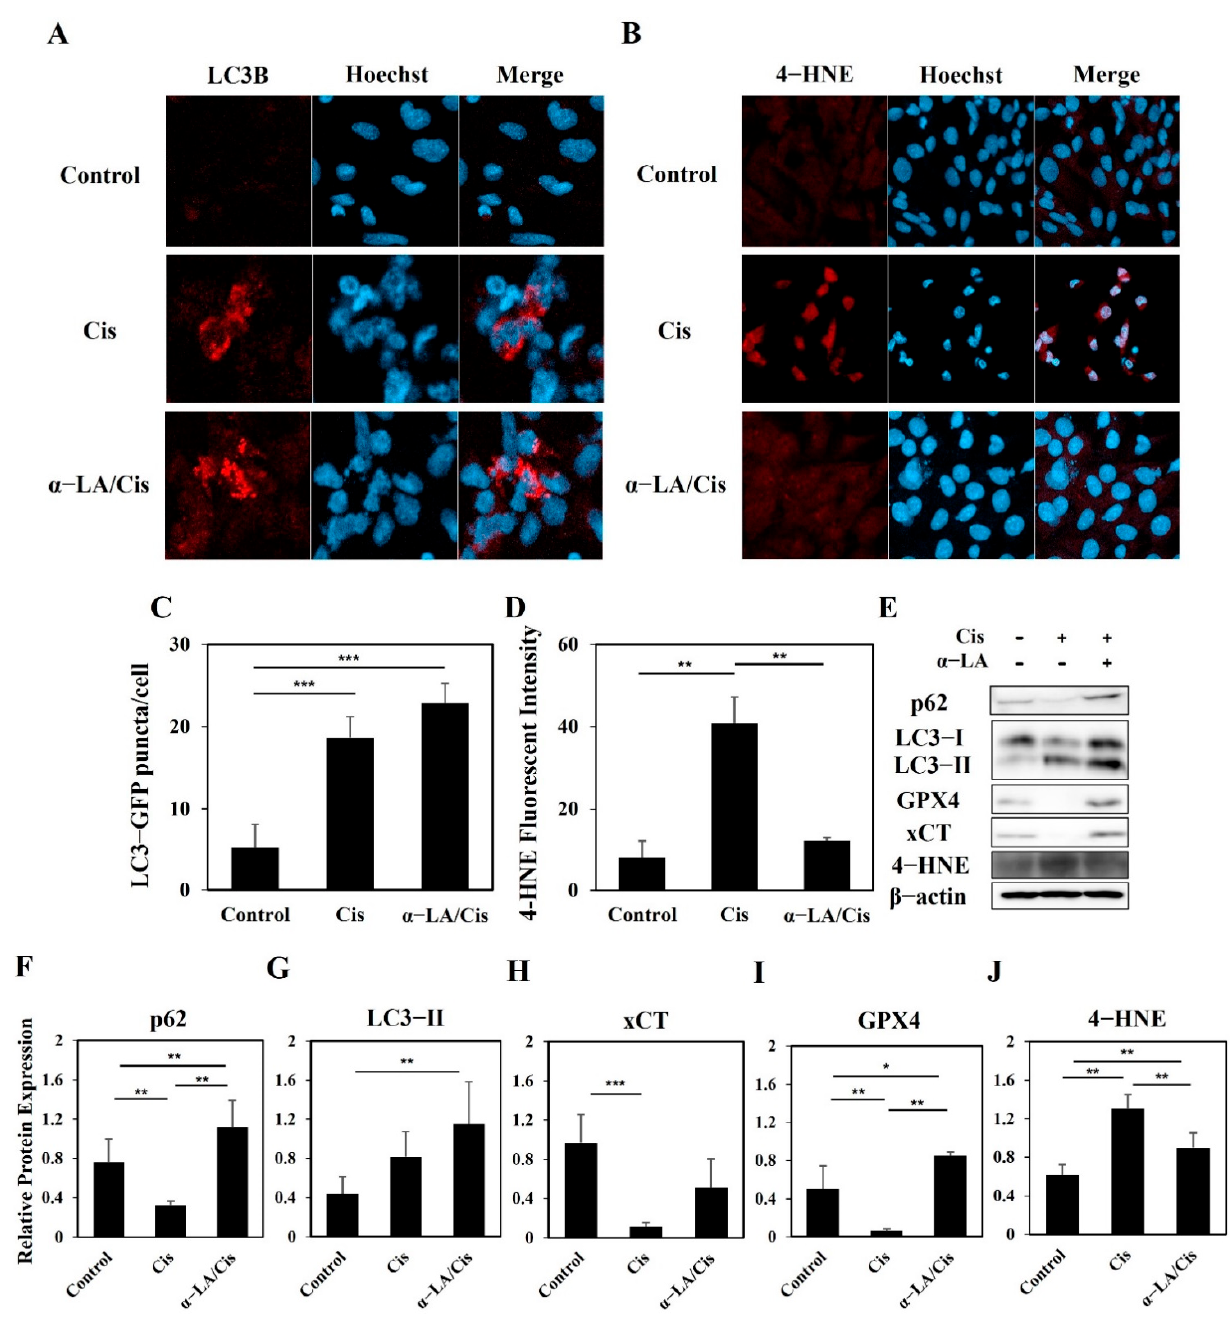
Figure 4. Fluorescence microscopic images and changes in cell death markers of HEI-OC1 cells caused by cisplatin-induced ototoxicity. ( A ) Immunofluorescence staining for LC3-B (red) (×400). ( B ) Immunofluorescence staining with 4-HNE (red) (×400). ( C , D ) Both the cisplatin and α -LA/Cis groups showed high fluorescence intensities of LC3-II, while only the α -LA/Cis group showed low intensity of 4-HNE. ( E – J ) According to the protein expression result, the α -LA/Cis group had significantly recovered expression of GPX4, which leads to low expression of 4-HNE. The data are presented as the means ± SDs of triplicate determinations from three independent experiments (* p < 0.05, ** p < 0.01, and *** p < 0.001, determined using one-way ANOVA).